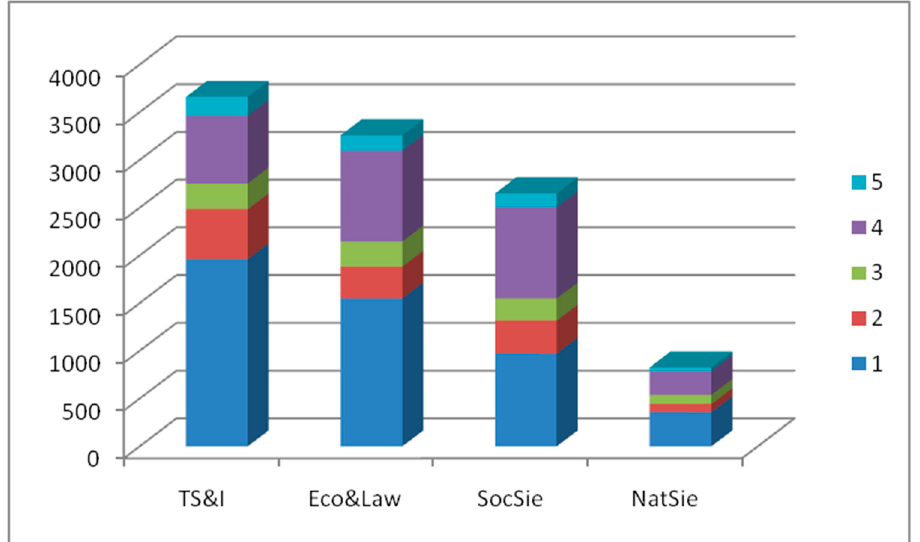
Figure 2. Structure of employed respondents based on their satisfaction or dissatisfaction with their studies.Note: 1 = graduates would choose the same field of study at the same university (satisfaction with the study at the university); 2 = graduates would choose another field of study at the same university (dissatisfaction with the field of study); 3 = graduates would choose the same field of study at another university (dissatisfaction with the university); 4 = graduates would choose another field of study at another university(dissatisfaction with both, field of study and the university as well); 5 = graduates would not study at the university (dissatisfaction with the university study in general).